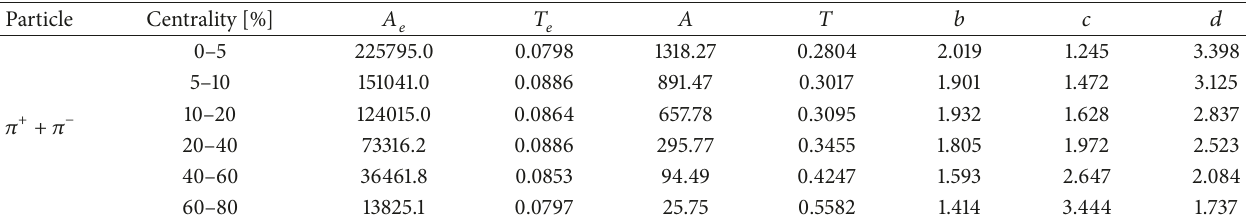
Table 3: The fitting parameters for pions with the hydrodynamic extension of the generalized FP solution